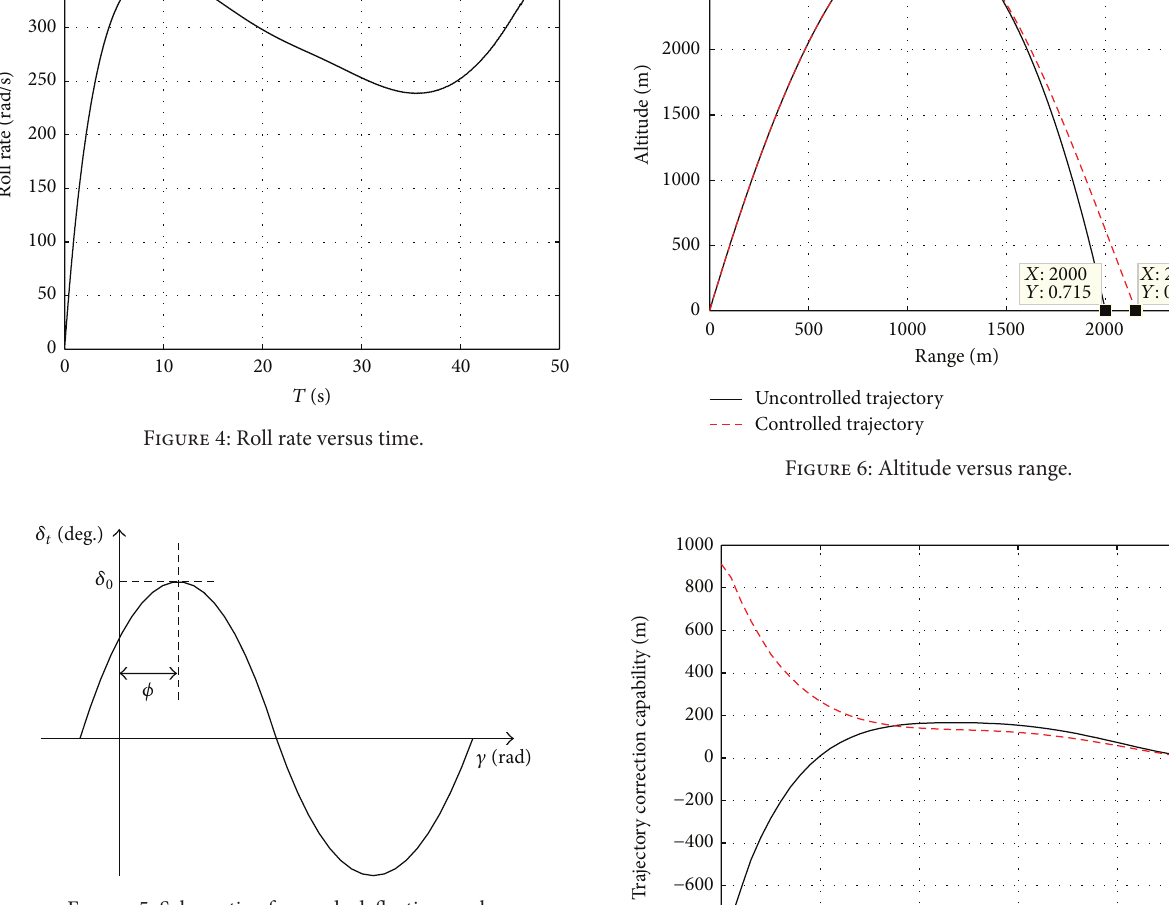
Figure 5: Schematic of canards deflection angle.